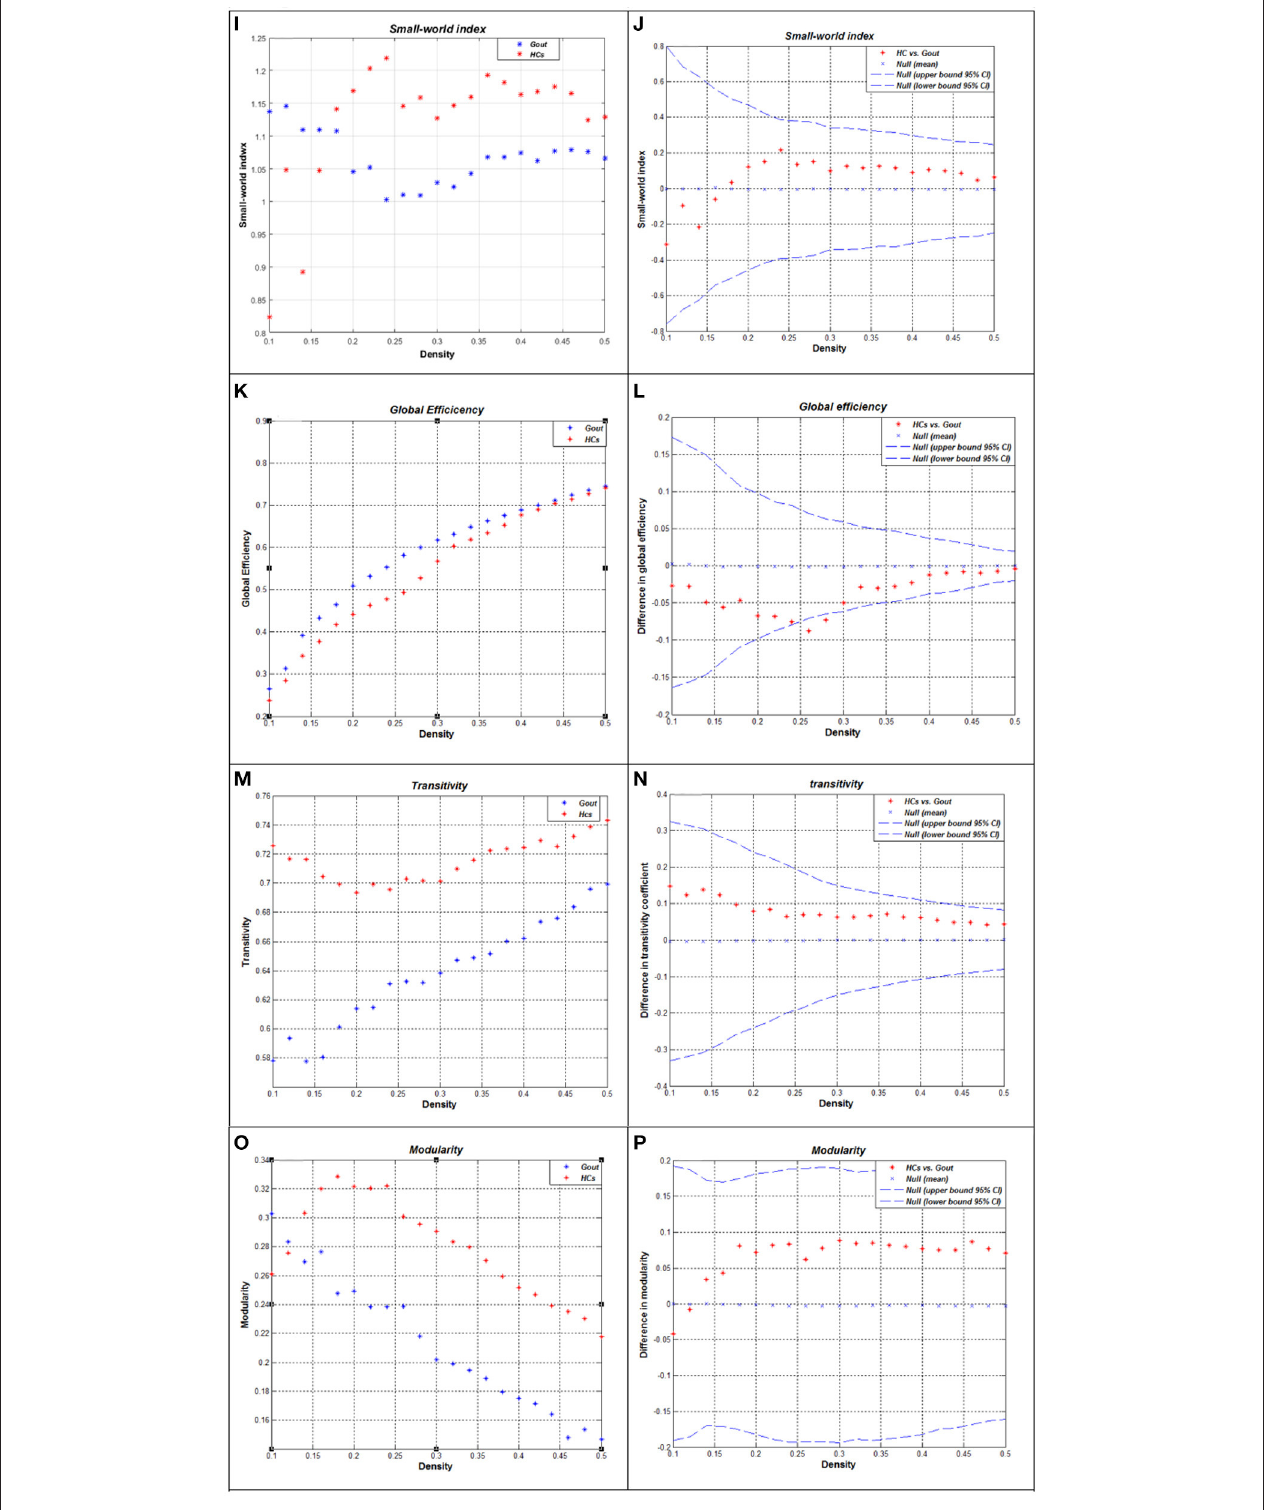
FIGURE 3 | Global network measures of two groups and between-group differences in these measures. Clustering coefficient (A,B) , characteristic path length (C,D) , gamma (E,F) , lambda (G,H) , small-world index (I,J) , global efficiency (K,L) , transitivity (M,N) , and modularity (O,P) of the Gout and HC networks. The red *